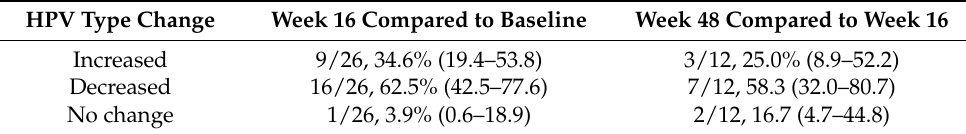
Table 4. Change in human papillomavirus types over period 1 and period